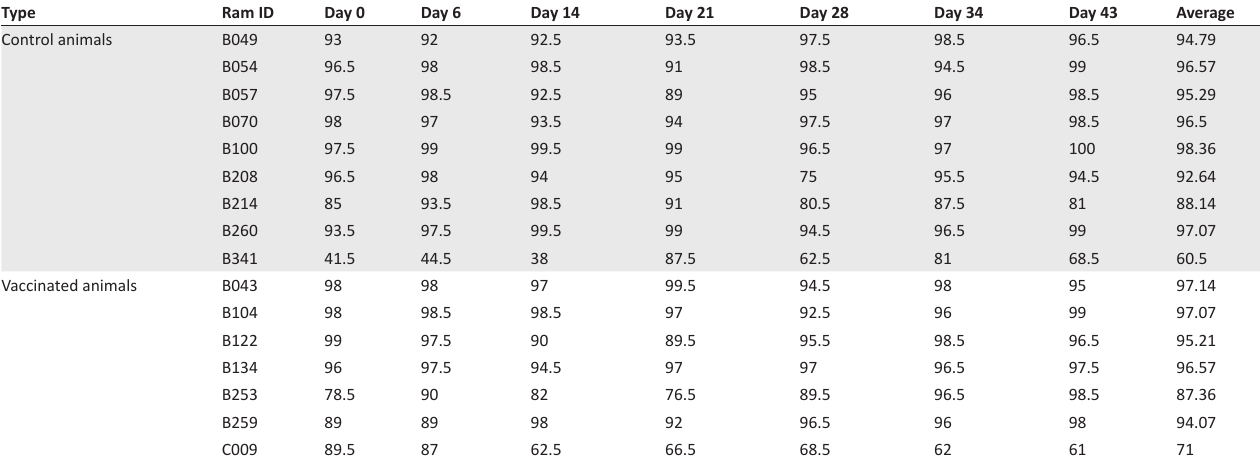
TABLE 4: Percentage morphologically normal sperm throughout trial.